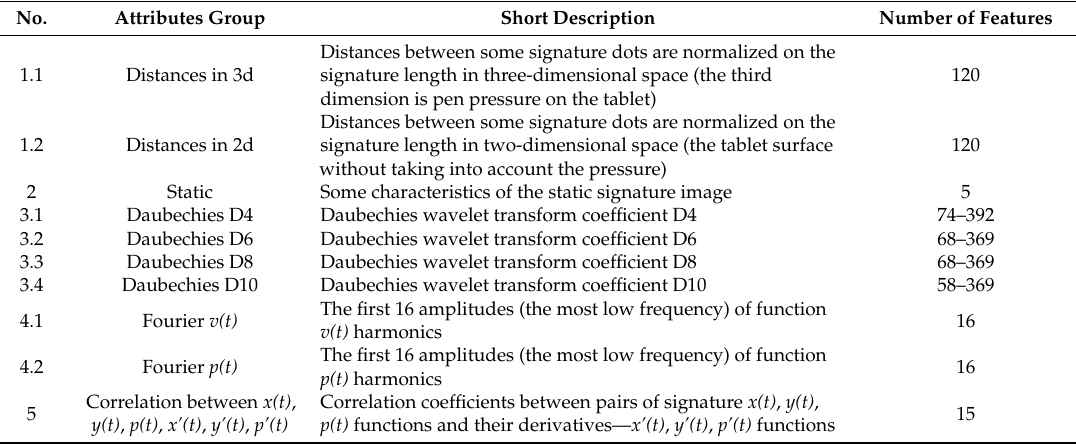
Table 1. Groups of features are used for key generation at present